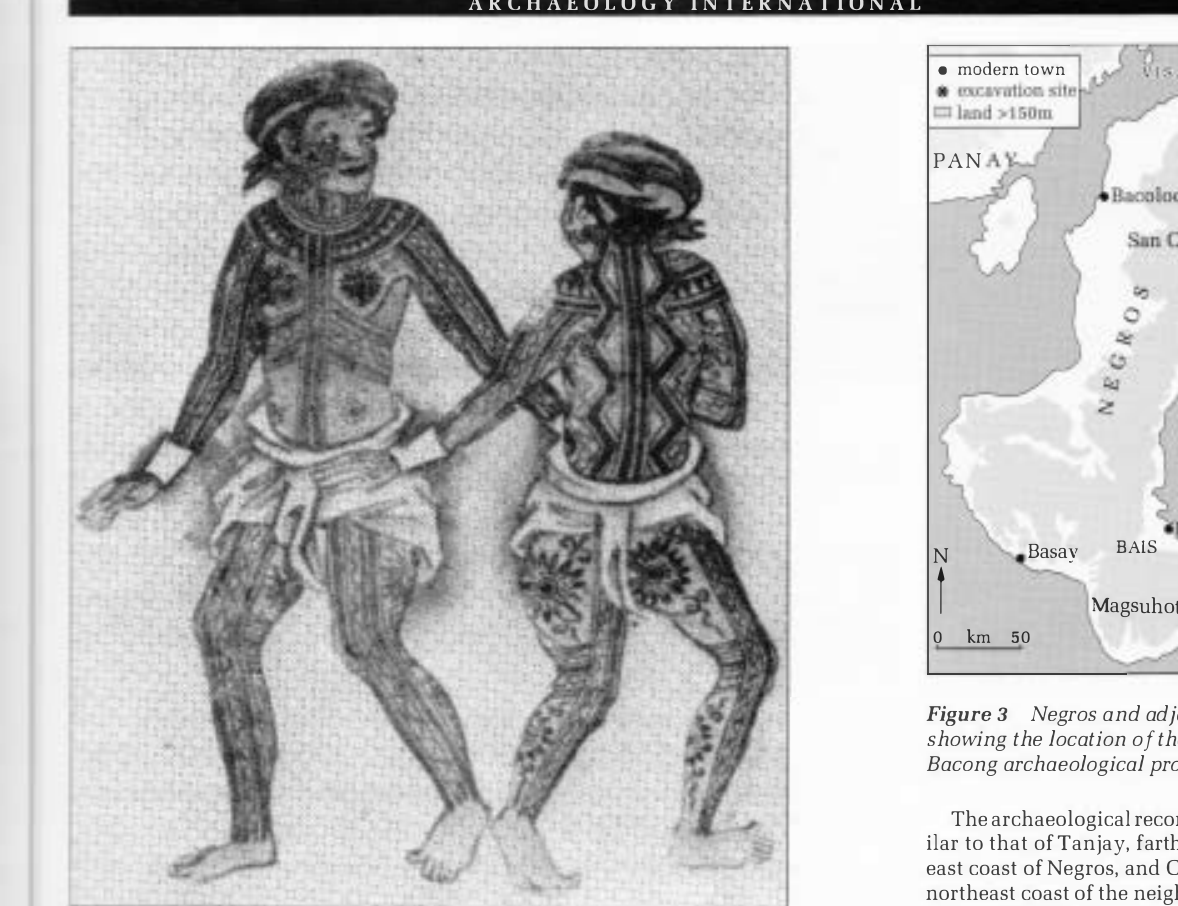
Figure 2 Two tatooed Visayans from the Philippine Islands, described by early Spanish explorers as "painted men".